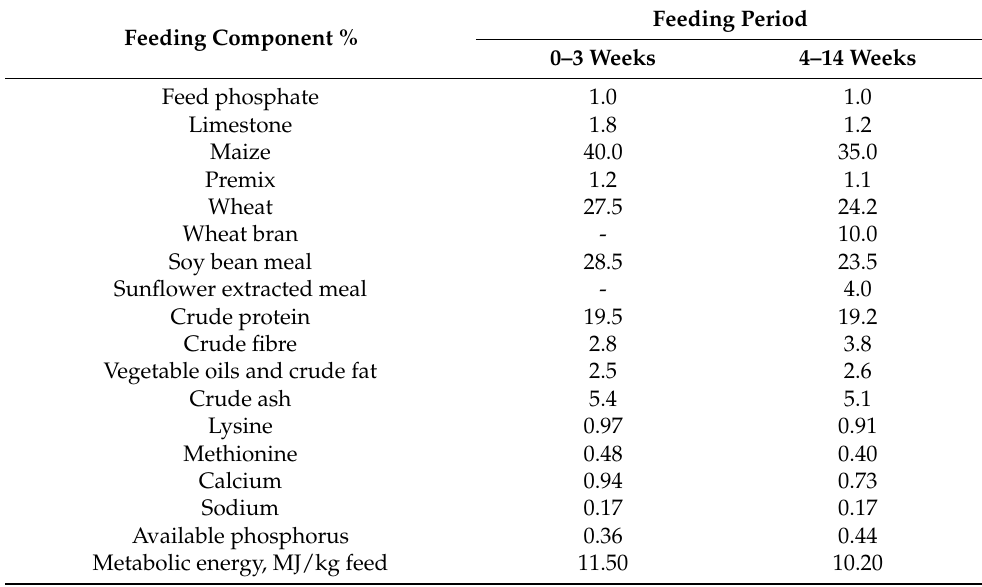
Table 2. Composition of concentrates and chemical composition of feed used in geese feeding